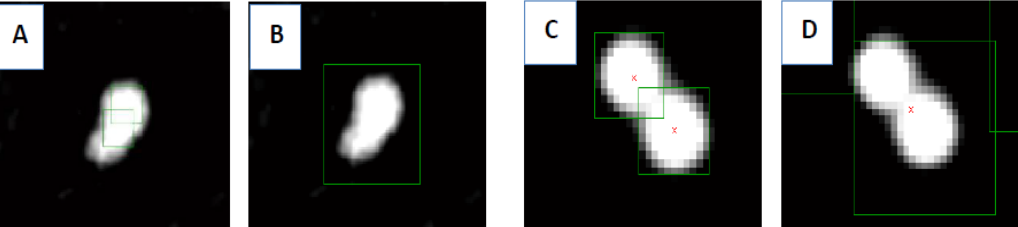
Figure 5. Particle detection and MP- E. coli complex recognition depend on proper adjustment of the detection parameters. Pictures ( A , B ) represent a loaded MP (MLB). Pictures ( C , D ) represent unloaded MPs: In ( A ), MLB is recognized as two separate objects (MP and E. coli are recognized separately) while, in picture ( B ), the complex is identified as a whole. In ( C ), two neighboring particles are distinguished as separate objects; on ( D ), they are marked as one. Proper adjustment of parameters must be done to obtain reliable results.